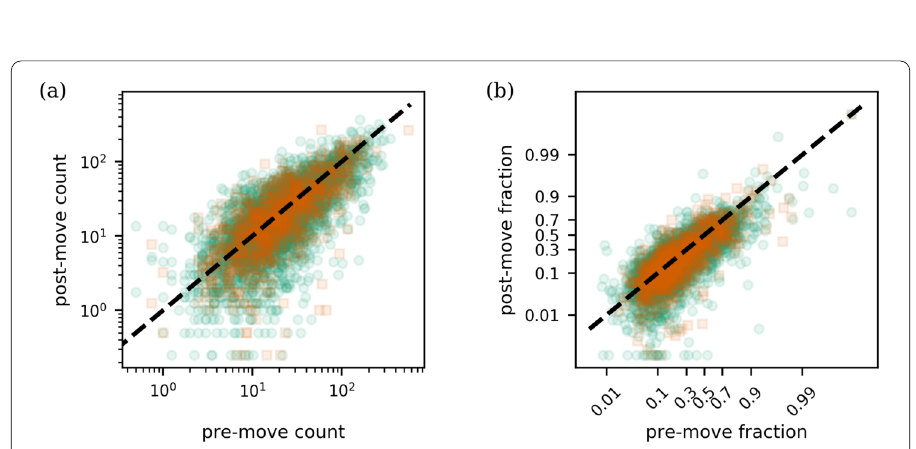
Figure 6 Post- vs pre-move number and fraction of calls. These plots show the post- vs. pre-move means of the ( a ) number of calls (log scale) and ( b ) fraction of calls (logit scale). Green circles refer to the train set and orange squares refer to the test set, while the dashed line corresponds to the y = x line. Note the clear linear trend and the considerable variance about the y = x line, indicating that although the pre-move value alone may give a rough estimate of the post-move value, it may not be enough to determine if the post-move value will be higher or lower than the pre-move value (above or below y = x